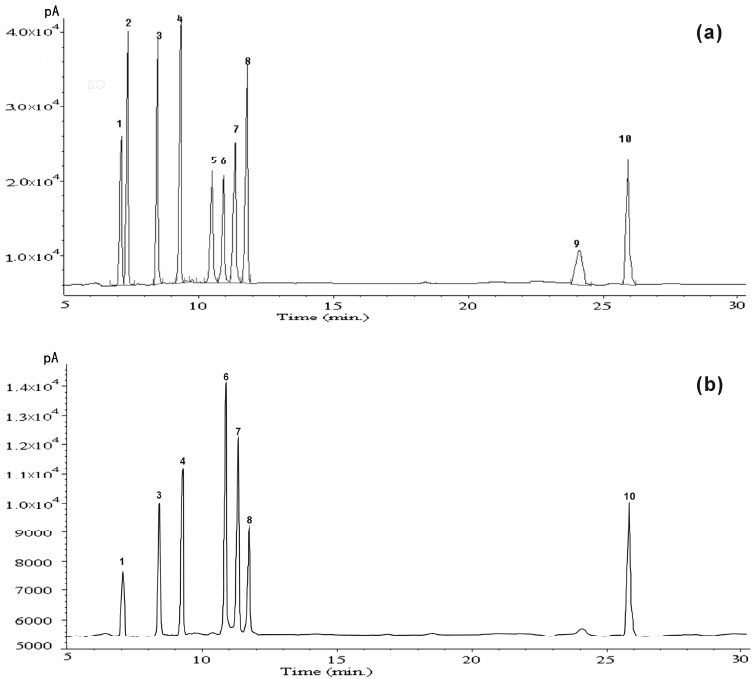
Figure 2. ( a ) Gas chromatography (GC) chromatogram of mixed standard monosaccharides derivatives; ( b ) GC chromatogram of hydrogen derivative from CPOP. Peak identification: 1: rhamnose, 2: